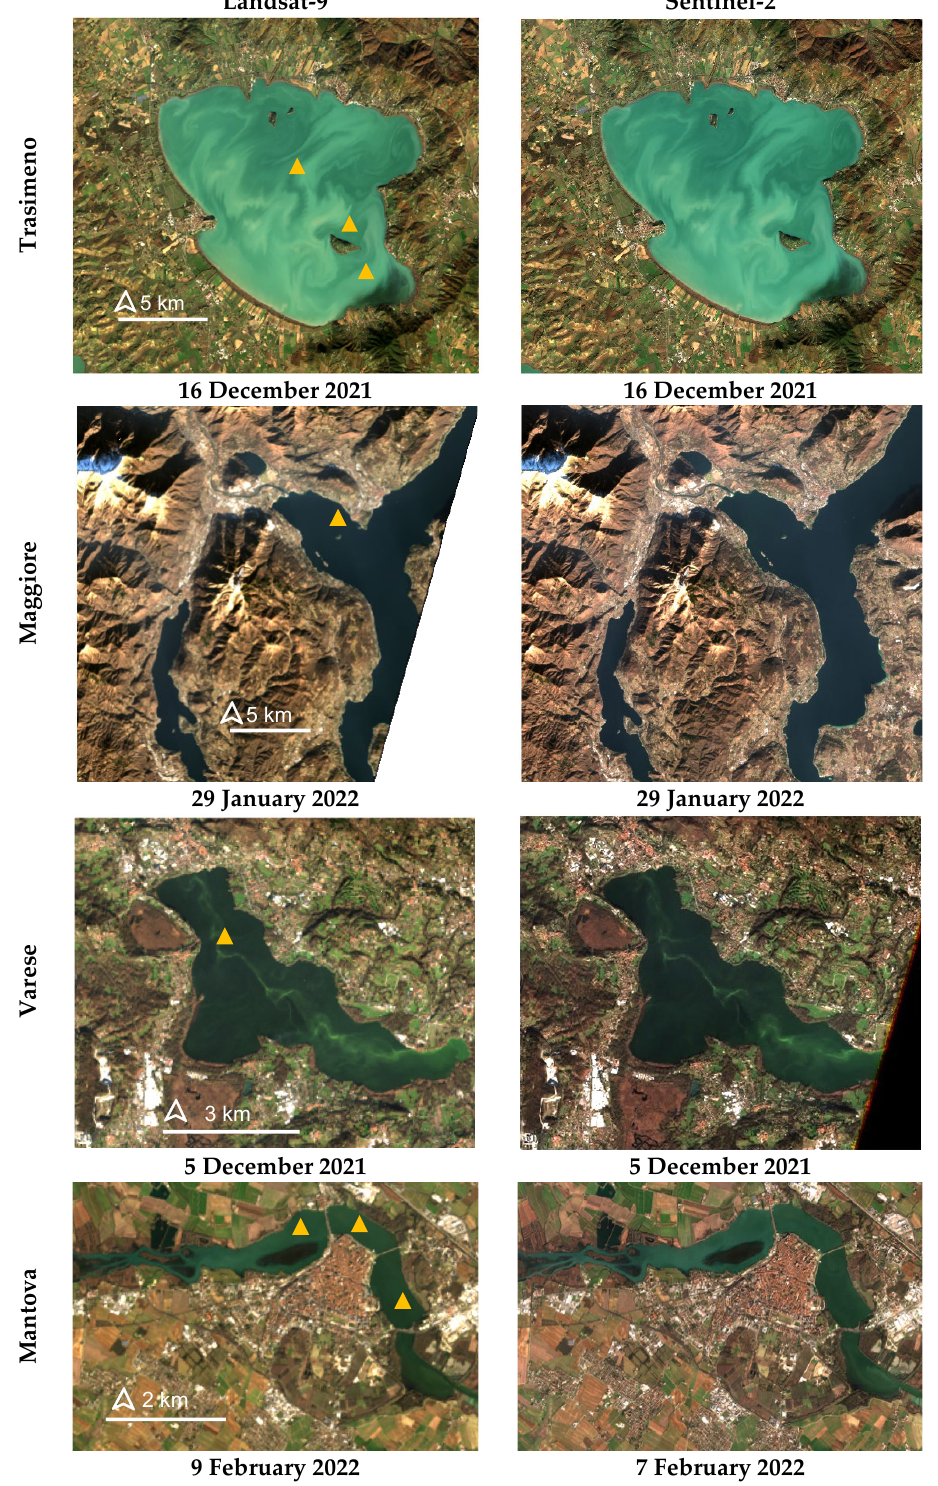
Figure 2. True color composite Landsat-9 and near-simultaneous Sentinel-2 images over four Italian lakes. The locations of in situ stations are shown on Landsat-9 images by yellow symbols.